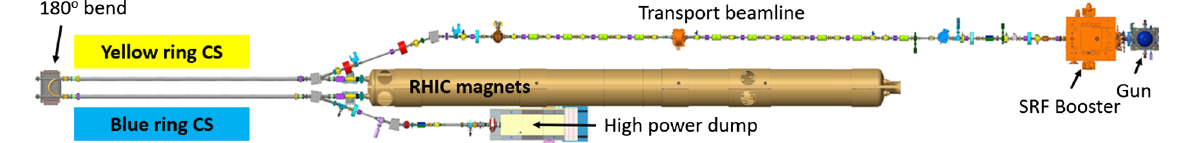
FIG. 5. Schematics of LEReC layout (not to scale).